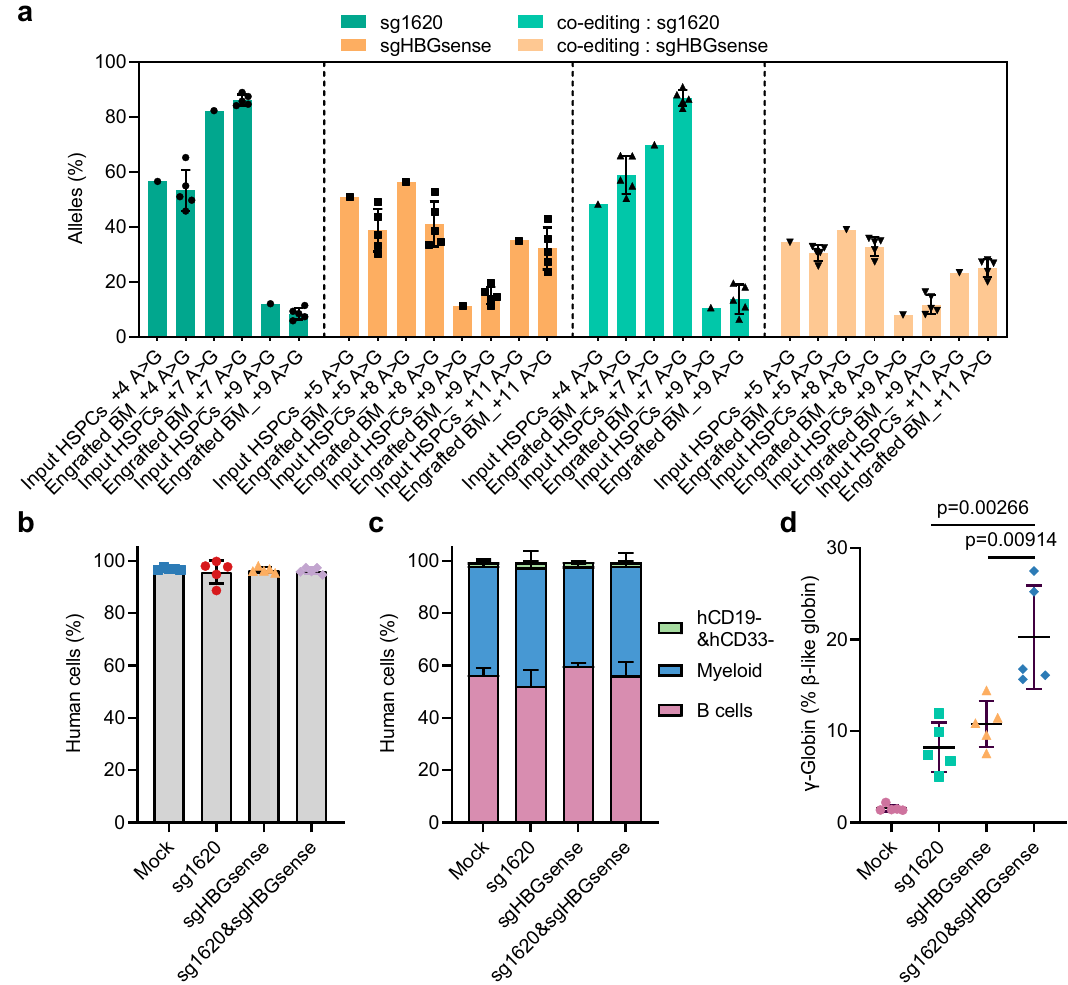
Fig. 2|Ef fi cientA>Gbaseediting inHSCsfromhealthydonor.a Baseeditingin unfractionated BMafter16 weeksascomparedto input HSPCs. Data areplottedas mean±sd. n =5 primary recipients for each group of edited HSPCs. b Comparing human chimerism of mock with all edited groups. Data are plotted as mean±sd. n =5 mice from mock and all edited groups. c Percentage of engrafted human B cells, myeloidcells and CD19 − CD33 − cells16weeksafter transplantation. Data